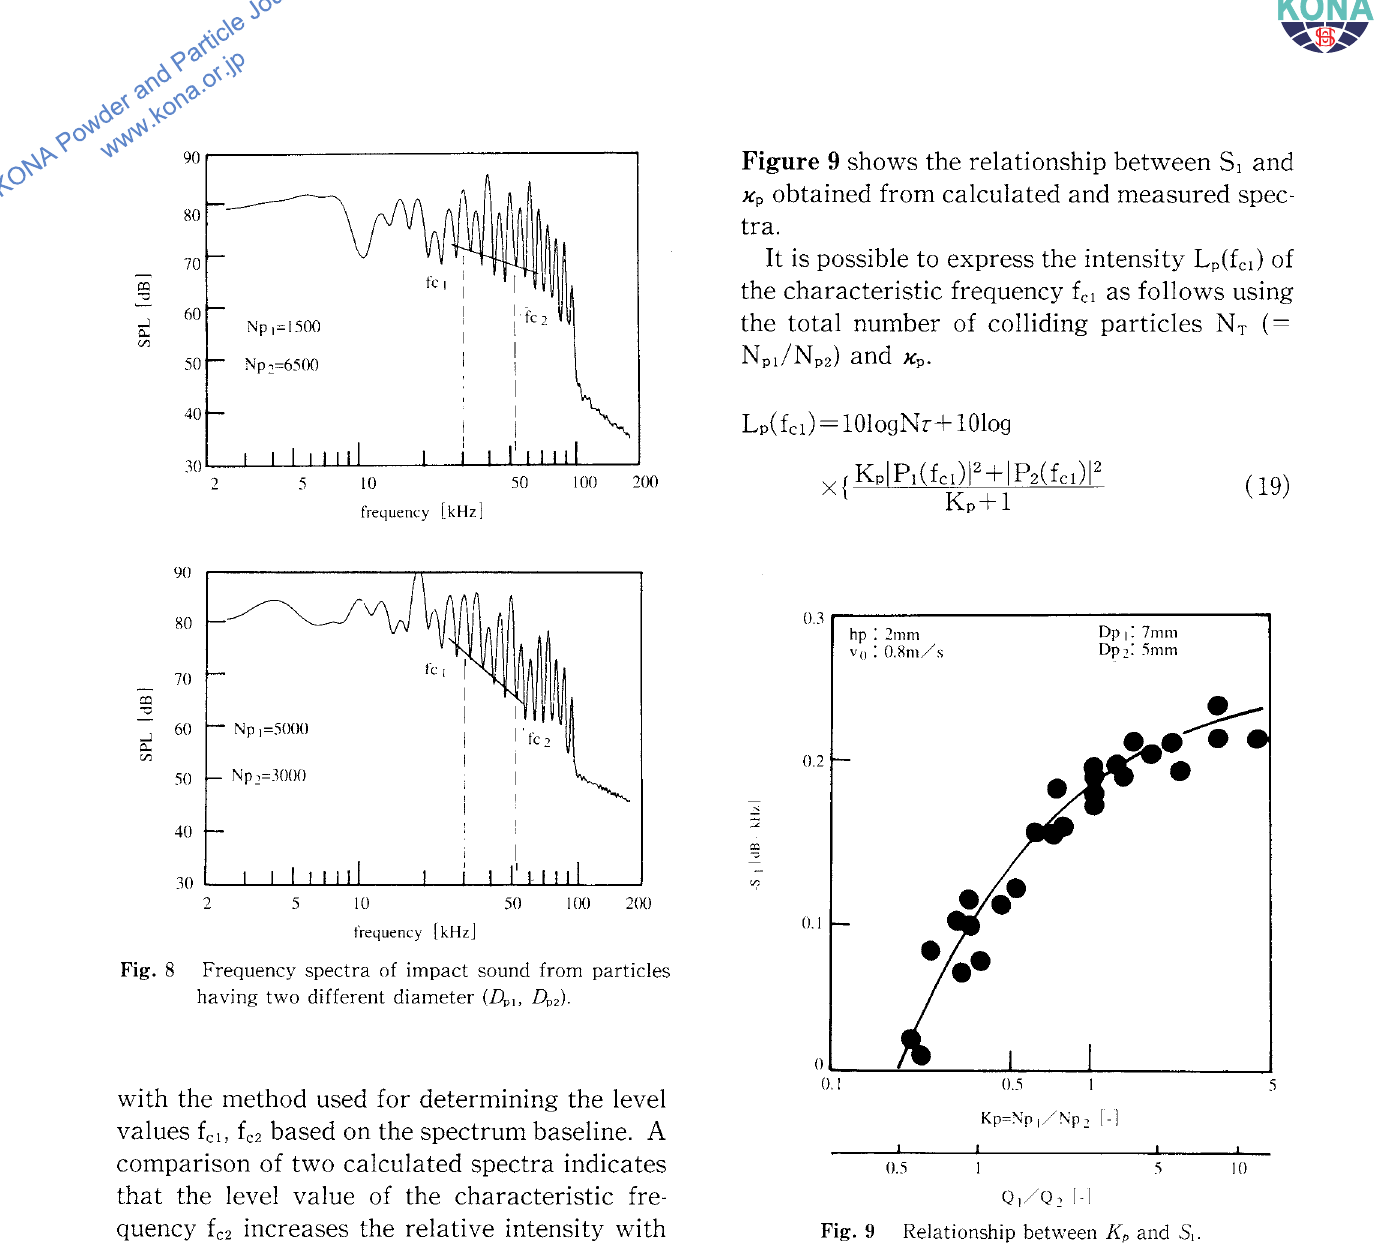
Fig. 9 Relationship between KP and S1.